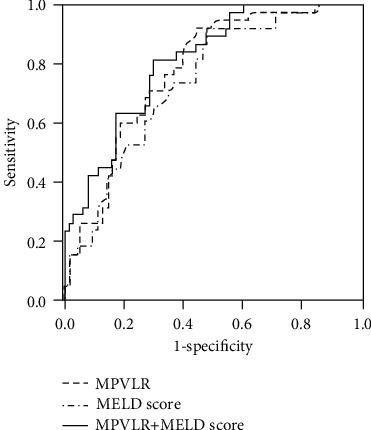
Receiver operating characteristic curves indicating the relative efficiencies of MELD score, MPVLR, and the combination of both for predicting 3-month mortality in patients with HBV-DeCi.